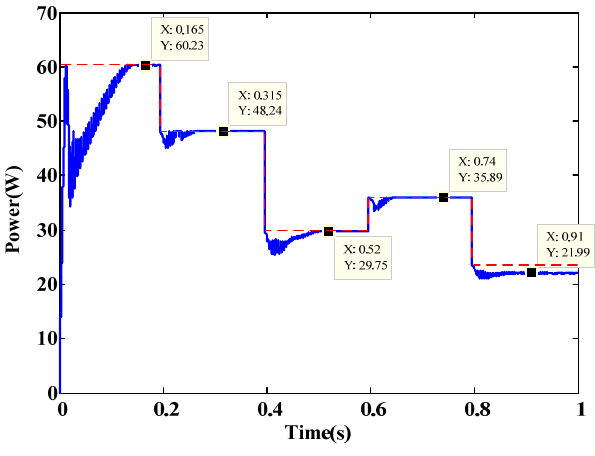
Figure 15. Simulation results for Algorithm